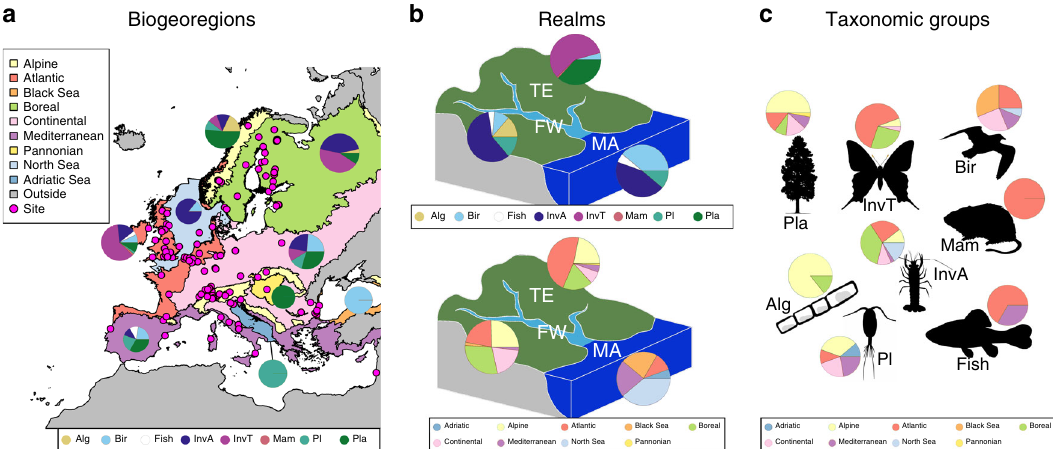
Fig. 1 Distribution of the time series across biogeoregions, realms and taxonomic groups. a Relative distribution of studied taxonomic groups across biogeoregions (magenta dots: study sites). Note that the most south-eastern site (in Israel) belongs to the Mediterranean region. b Relative distribution of studied taxonomic groups and biogeoregions across realms. c Relative distribution of studied biogeoregions across taxonomic groups. FW freshwater, MA marine and transitional zone, TE terrestrial, Alg benthic algae, Bir birds, InvA aquatic invertebrates, InvT terrestrial invertebrates, Mam mammals, Pl plankton, Pla terrestrial plants. The pie charts show the proportion of taxonomic groups for each biogeoregion and realm, and the proportion of biogeoregions for each realm and taxonomic group. The shape fi les of the biogeographical regions and marine subregions were obtained from EEA 74 . Drawings of taxonomic groups are from phylopic.org. Source data are provided as a Source Data fi